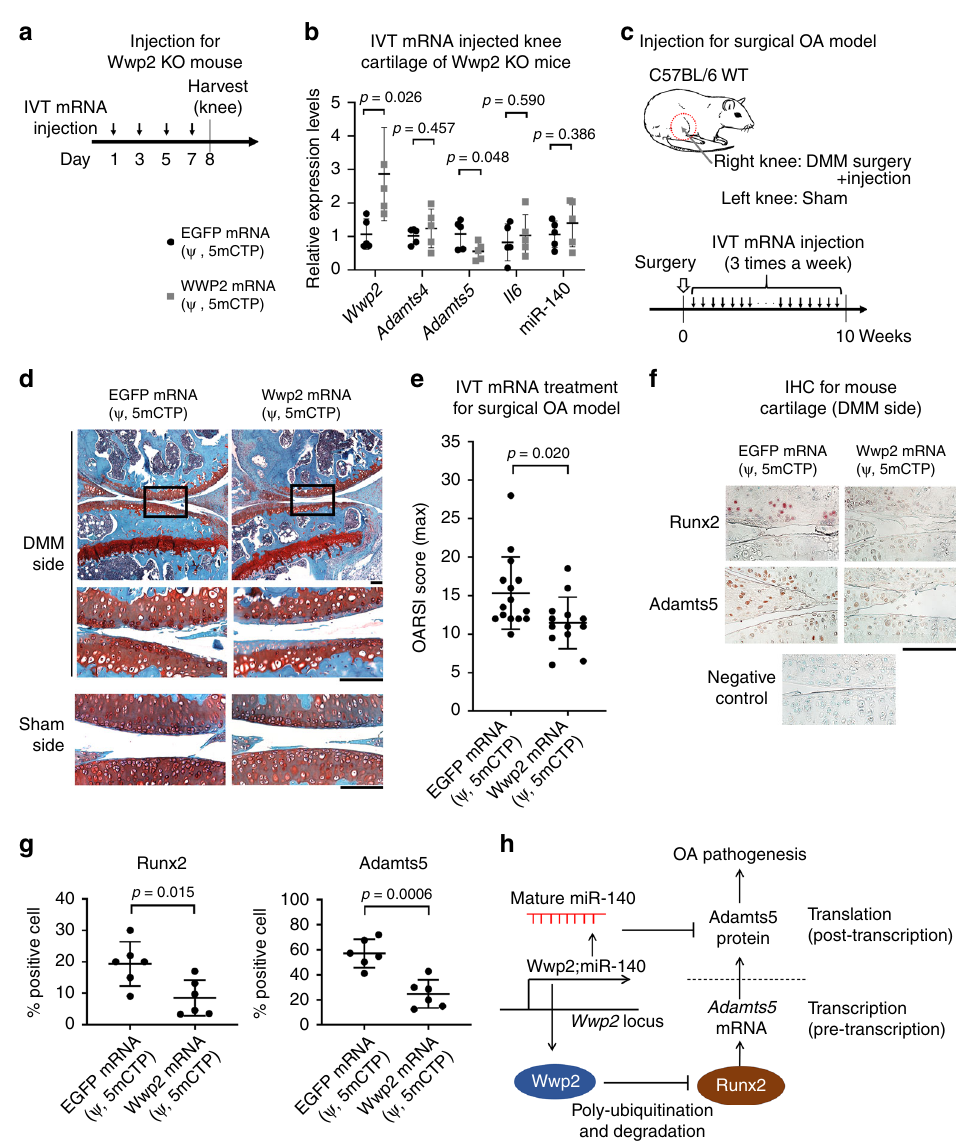
Fig. 7 In vitro transcribed Wwp2 mRNA prevents mouse articular cartilage destruction. a , b Effect of in vivo intra-articular injection of IVT mRNA on gene expression in cartilage. IVT Wwp2 (or control EGFP) mRNAs ( ψ , 5mCTP) with atelocollagen and Invivofectamine 3.0 reagent were injected into knee joints of Wwp2 KO mice. a Schedule of in vivo transfection. b RT-qPCR for OA related genes in Wwp2-transfected cartilages from injected 3-month-old Wwp2 KO mice ( n = 5, Student ’ s t test, normalized with Gapdh or U6snRNA). c – e Treatment using IVT Wwp2 mRNA ( ψ , 5mCTP) against surgically induced OA model in C57BL/6 mice. c Schedule of treatment. d Representative images of Safranin-O staining. e The maximum OARSI scores ( n = 13-15, Student ’ s t test). f , g IHC of Runx2 and Adamts5 for IVT mRNA-treated mouse articular cartilage. f Representative images. Negative control was stained using rabbit control IgG. g Runx2 and Adamts5 positive cell rates ( n = 6, Student ’ s t test). h Summarized schema of this study. Black scale bar = 1 mm. Source data are provided as a Source Data fi le. Data are presented as the mean ± ( Agc1 -CreER; Runx2 fl ox/ fl ox mouse) 33,34 , supporting the notion